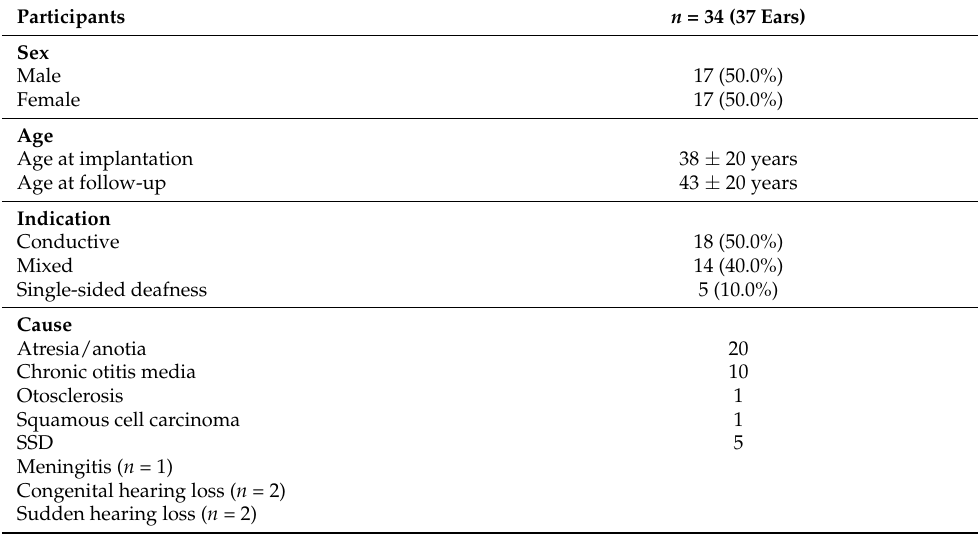
Table 1. Bonebridge users’